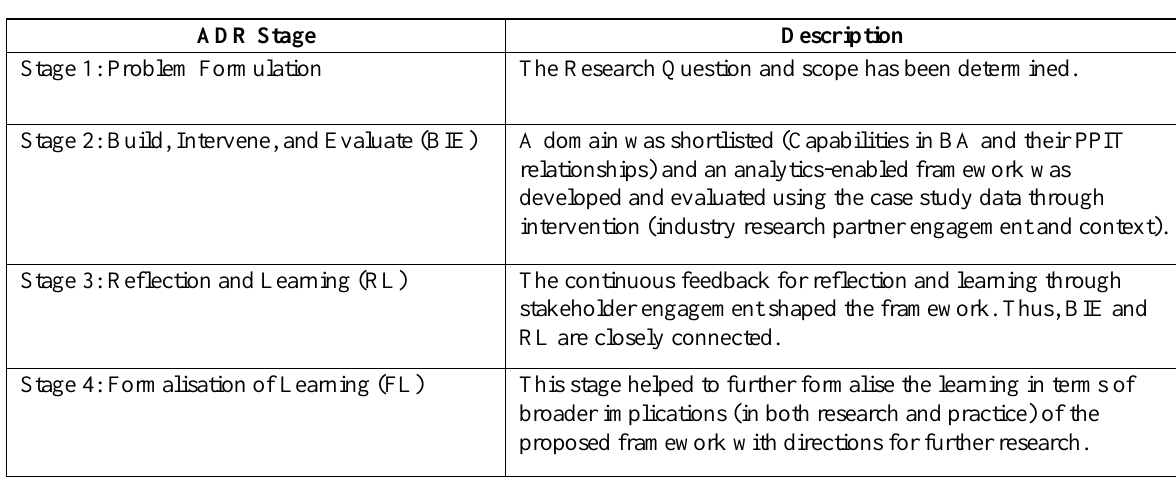
Table 2. Summary of the ADR method